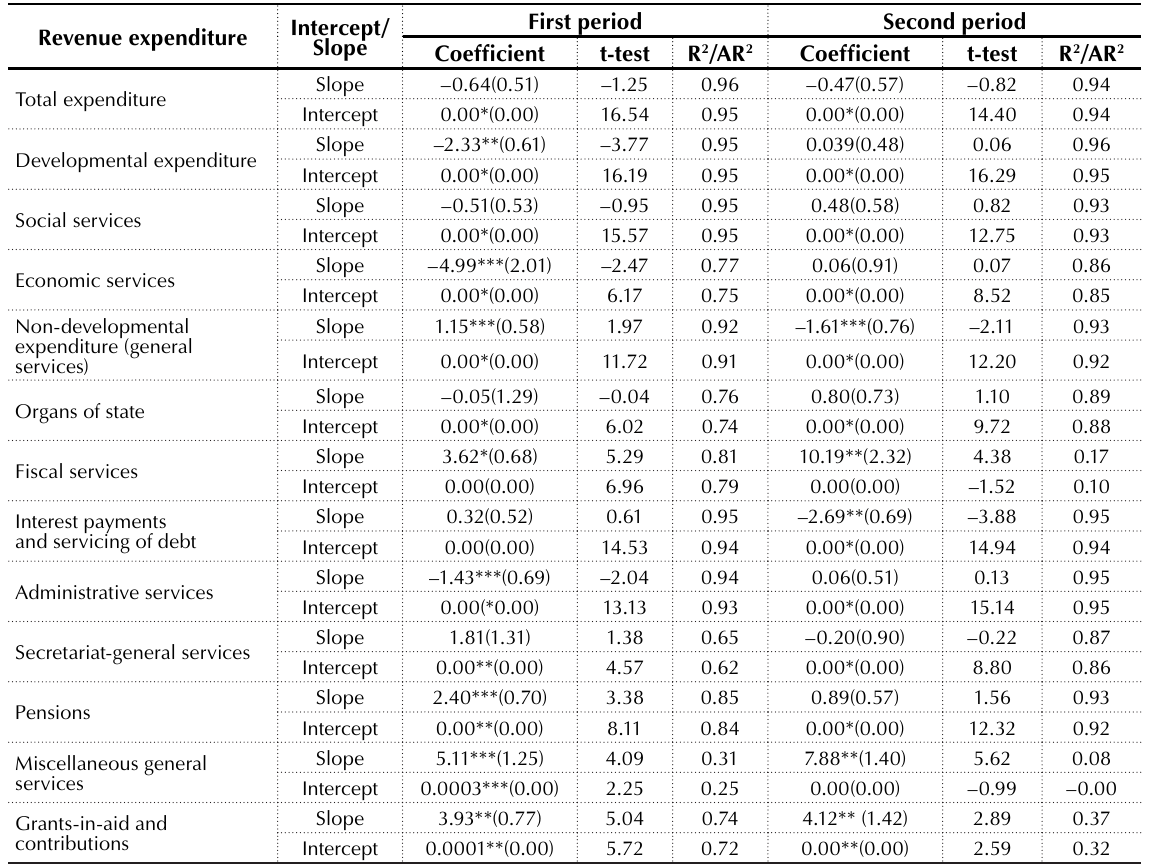
Table 6. Regression results for revenue